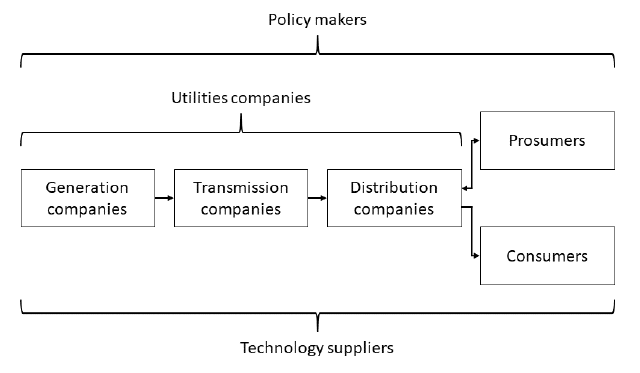
Figure 1. Energy market supply chain and